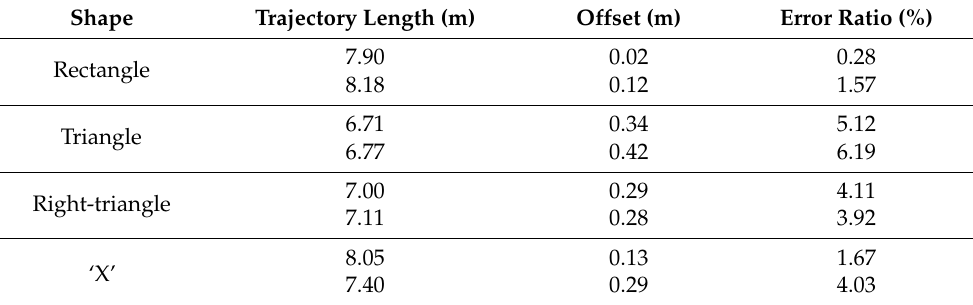
Table 1. Trajectory length and error ratio of each test using the proposed method. Shape Trajectory Length (m) Offset (m) Error Ratio (%) Rectangle